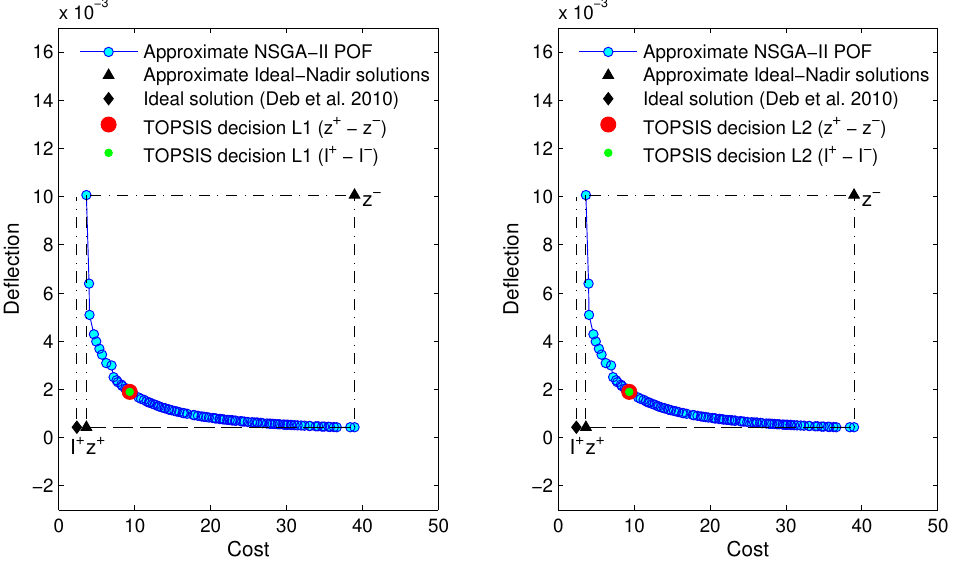
Figure 14. TOPSIS decision with L 1 ( left ) and L 2 ( right ) metrics on the approximate POF with the hypervolume indicator closest to the average value of hypervolume after 100 runs for NSGA-II ( N = 100).